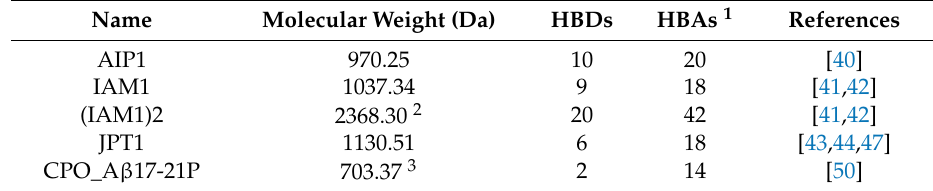
Table 2. Physicochemical properties for example antiamyloidogenic